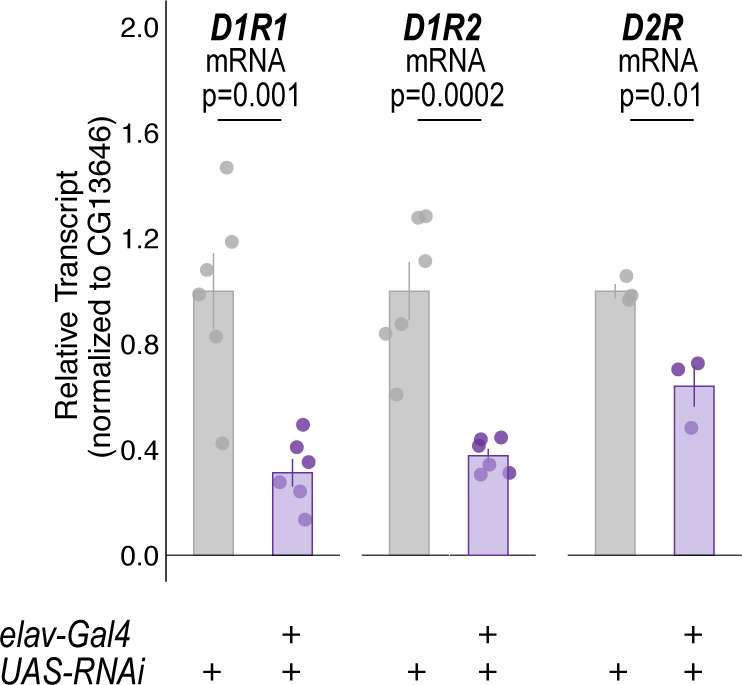
mRNA quantification of dopamine receptors (DRs) in all neurons following constitutive expression of DR-RNAi's.Quantitative RT-PCR on whole heads of flies expressing respective dopamine receptor RNAi with pan-neuronal elav-Gal4. Bar graphs illustrate mean +/- standard error of the mean. Raw data are overlaid on bar graphs. One-way ANOVA was used to compare mean and variance with Tukey Posthoc comparing control to experimental for each RNAi experiment.